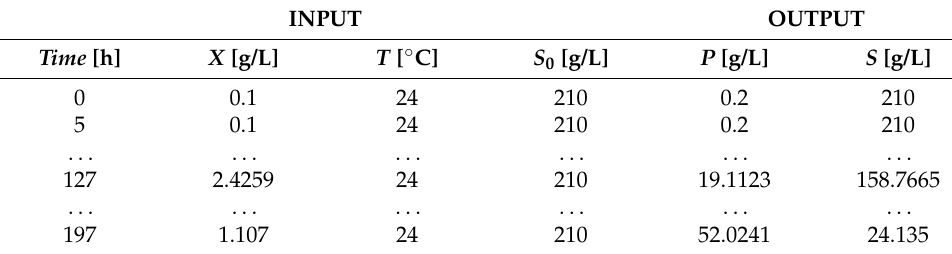
Table A1. Dataset organization spreadsheet for a fermentation temperature of 24 ◦ C.